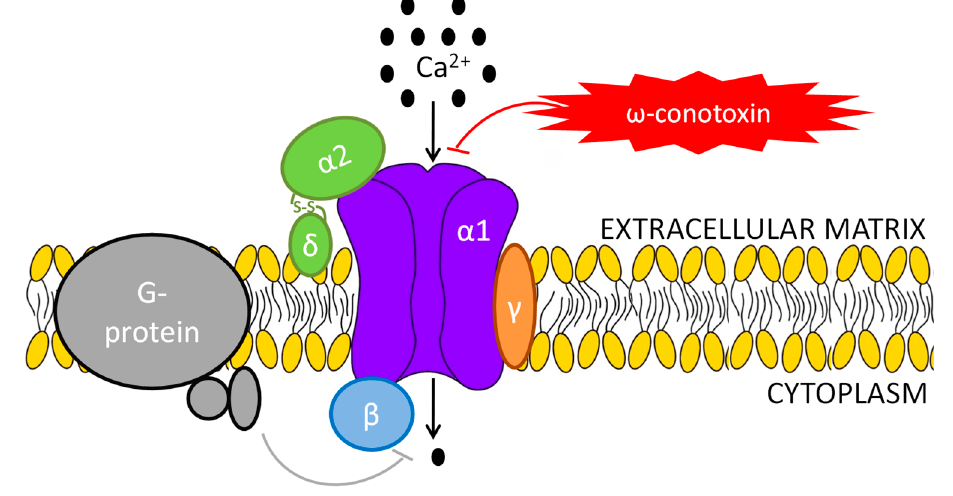
Figure 1. Schematic representation of the structure of the voltage-gated Ca 2+ channels. Table 1. Voltage-gated Ca 2+ channel types according to the α 1 subunit.